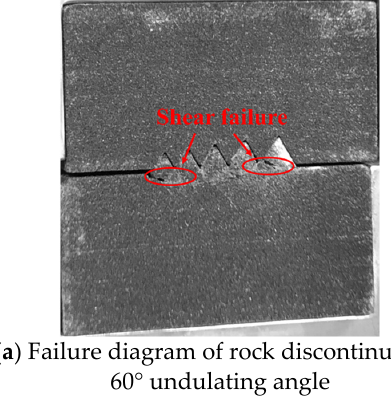
Figure 9. Shear test failure